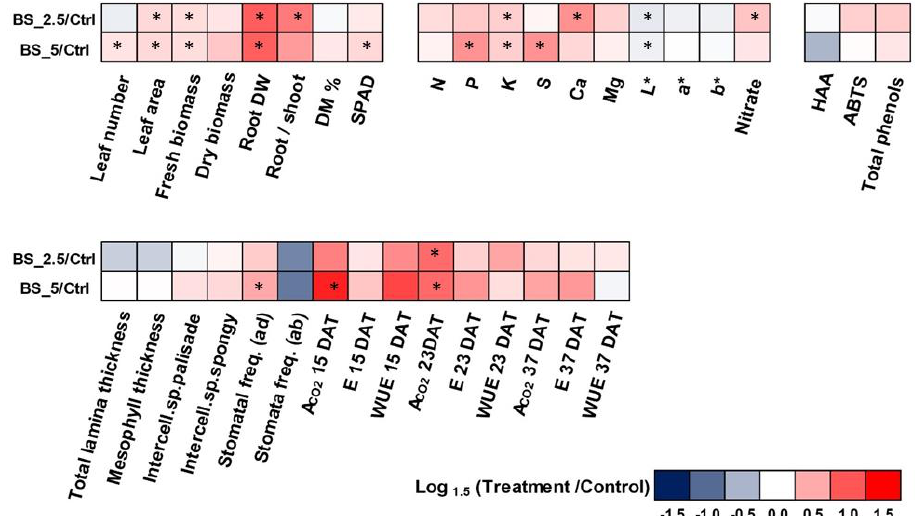
Figure 5. A heat map analysis summarizing lettuce plant responses to PH biostimulant 0.0, 2.5 and, 5.0 mL L – 1 dose. The heat map results were calculated as Logarithm base 1.5 (Log1.5) of Treatment/Control values and visualized using a false-color scale, with red indicating an increase and blue a decrease of values. No differences were visualized by white squares. * indicates significant difference at p < 0.05.